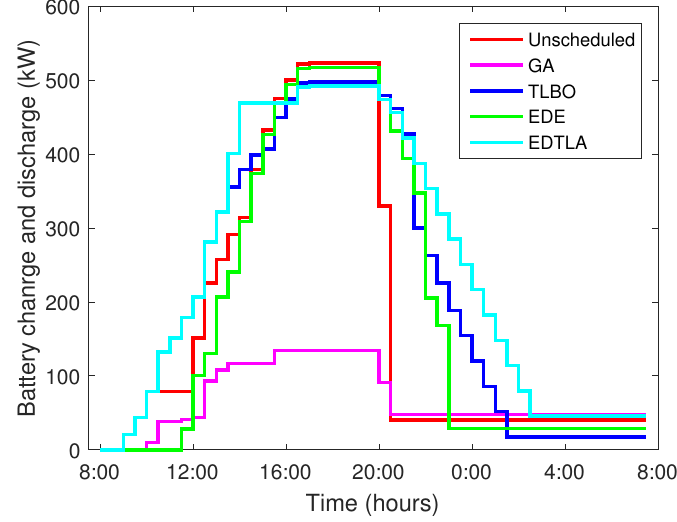
Figure 4. Battery charge and discharge